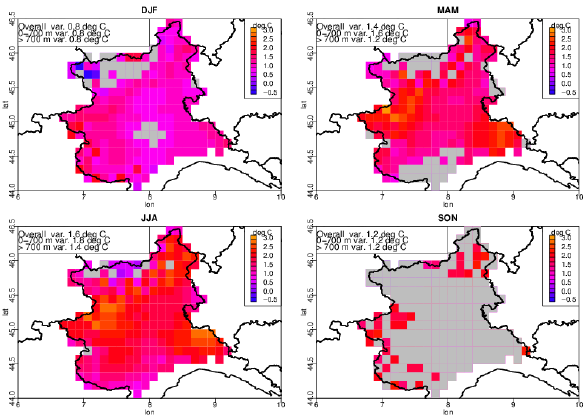
Figure 9: difference between the Multimodel SuperEnsemble scenario maximum temperatures averaged over the period 2031-2050 with respect to the period 1981-2000, as a function of the season (T-test conf. level 95%) in Piemonte region. In the upper left boxes overall averages over significant points and altitude bands averages are shown.